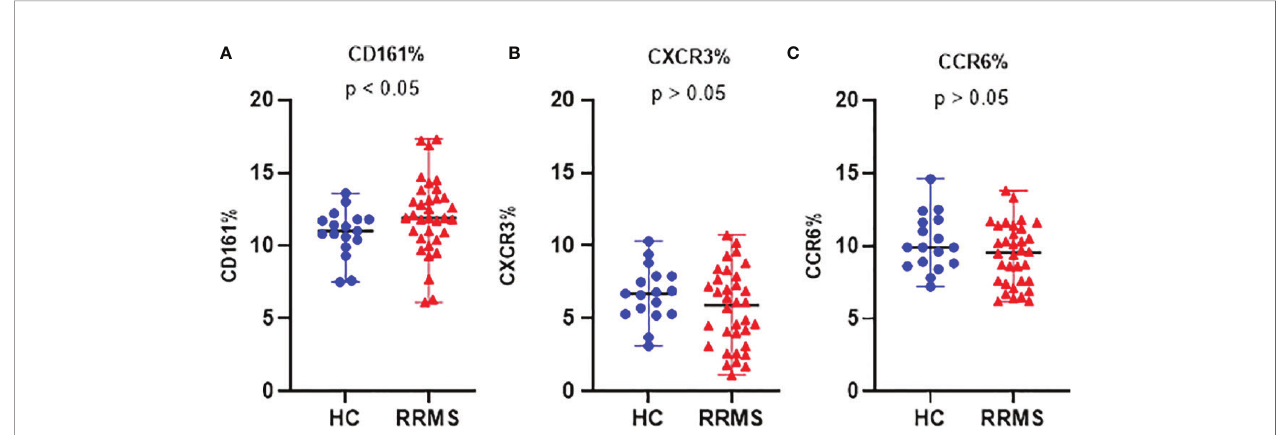
FIGURE 3 | The proportion of ex vivo CD161 (A) , CXCR3 (B) , and CCR6 (C) positive cells in HC and RRMS groups. Each dot represents one individual subject and horizontal bars indicate median values. Shown p -values were calculated using the median